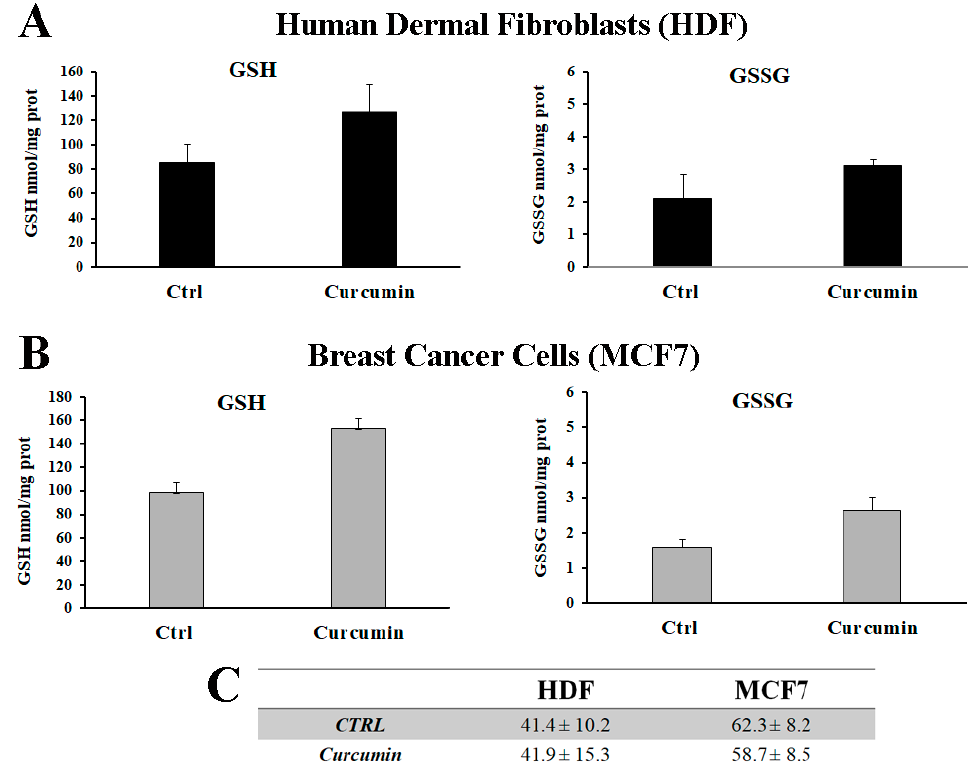
Figure 3. Effect of curcumin on glutathione levels in HDF and MCF7 cell lines. Quantification of total cellular GSH and GSSG of HDF ( A ) and MCF7 cells ( B ). Analysis was performed using a DTNB-glutathione reductase recycling assay and the amount of GSH and GSSG was normalized to protein content. ( C ) GSH:GSSG ratio. Values are expressed as the mean ± SD of six separate